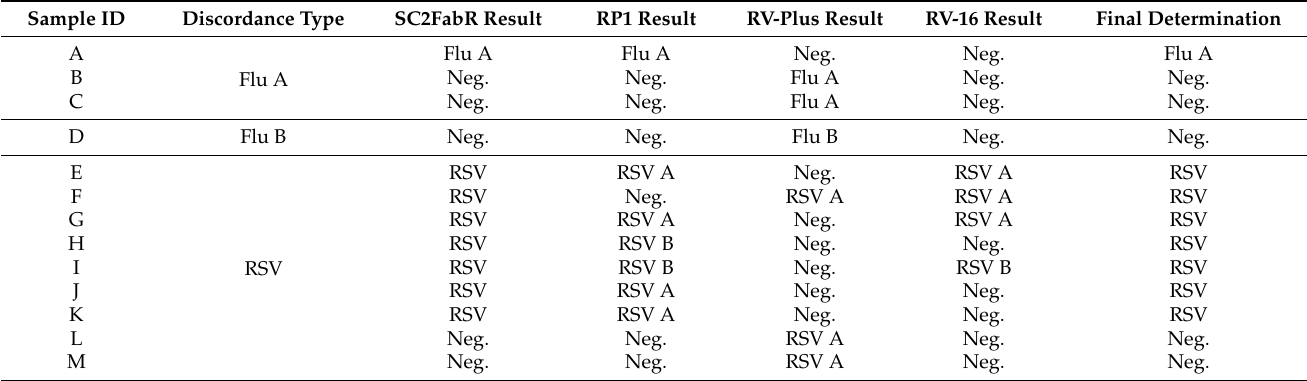
Table 3. Resolution of discordant sample identification by comparing test assay and RV-16 assay performance. Sample